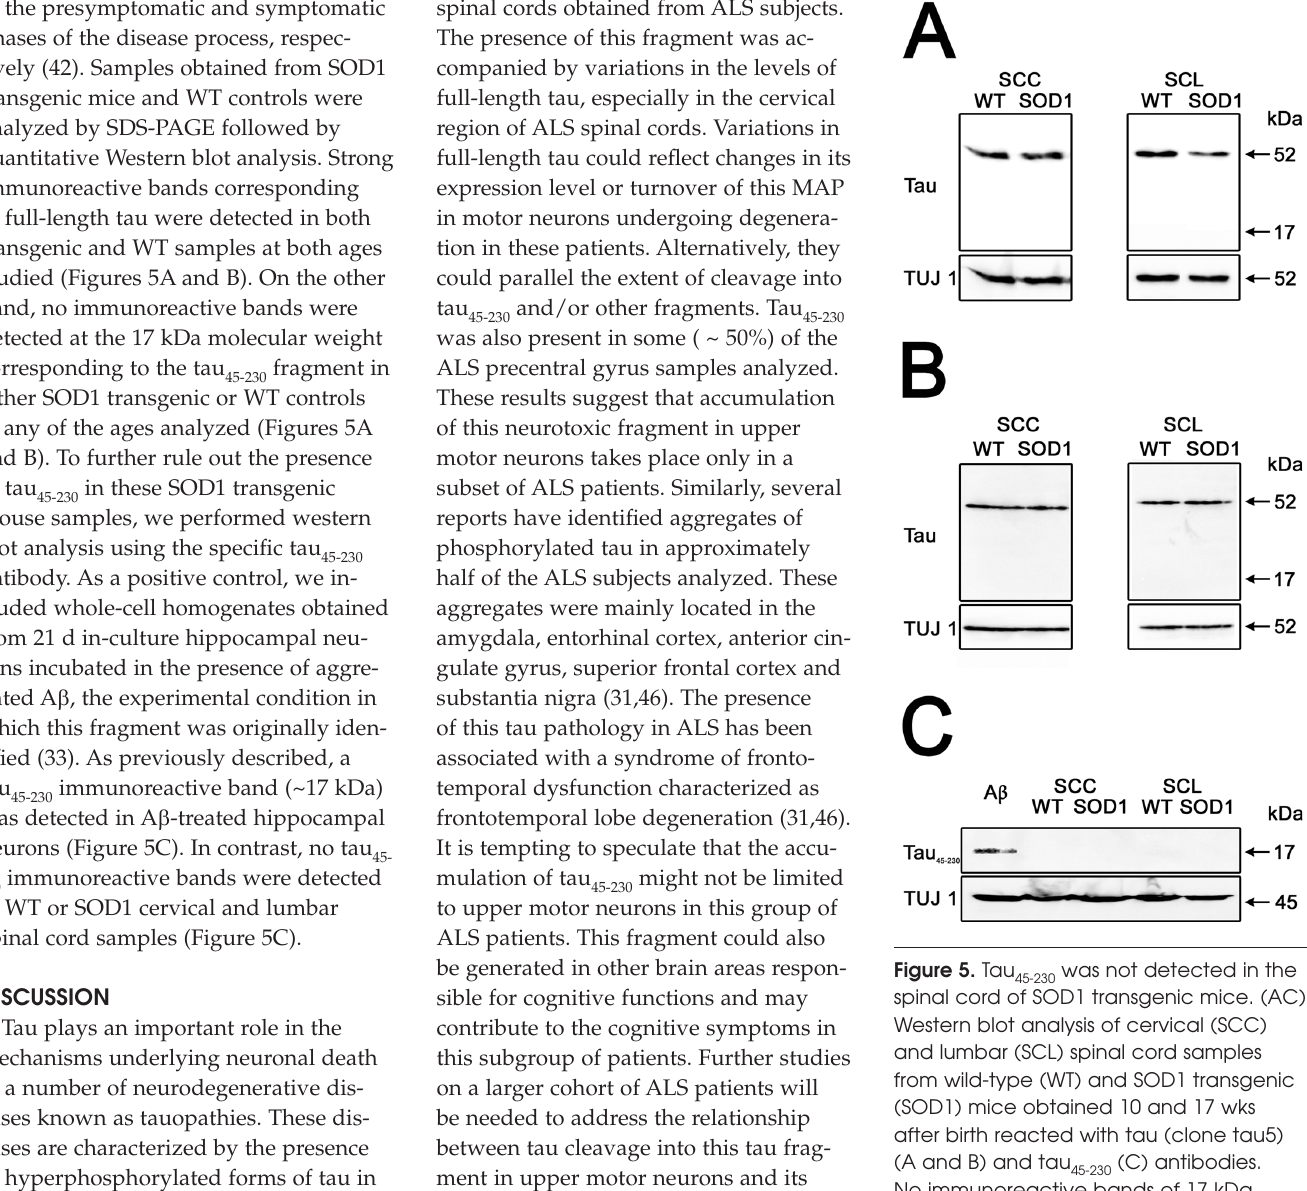
positive control (C). Class III β tubulin (TUJ1) was used as loading